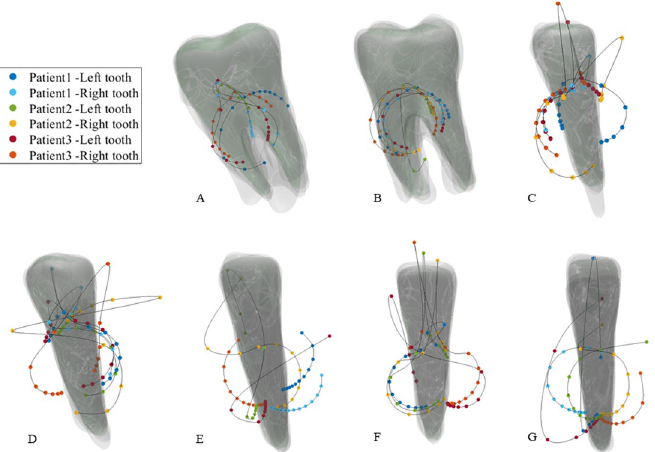
Fig 4. CRots trajectories of registered teeth in scenario 1. Trajectories of the obtained CRots for the different patients’ teeth registered to the reference teeth of the same types and shown as transparent teeth. A : The second molars. B : The first molars. C : The second premolars. D : The first premolars. E : The canines. F : The lateral incisors. G : The central incisors. A consistent loading condition is applied to all teeth of the same types, and the magnitude of the couple changes from 1N to 13N. Note that a few extreme outliers are discarded for a better illustration